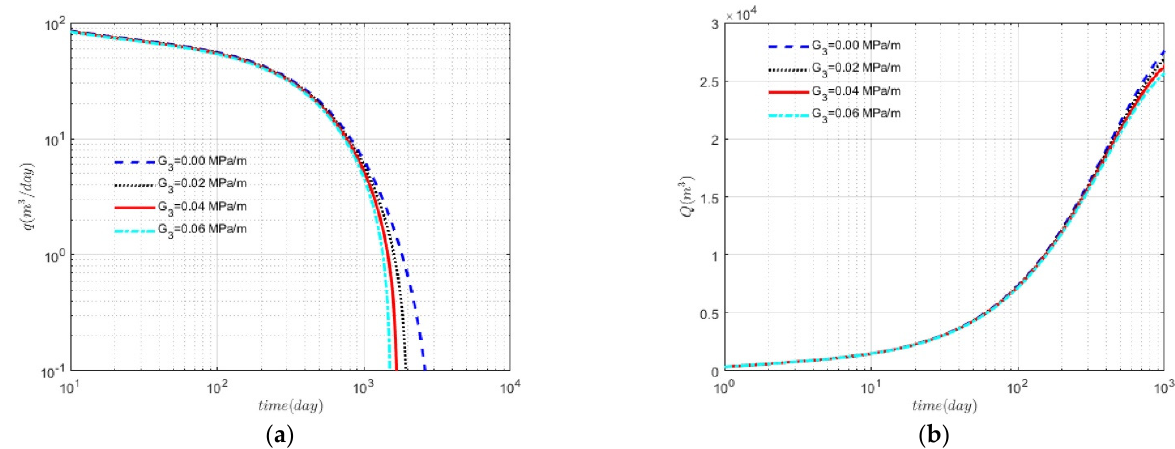
Figure 10. The effect of the threshold pressure gradient on productivity: ( a ) effect of the threshold pressure gradient on well production rate; ( b ) effect of the threshold pressure gradient on cumulative production rate.